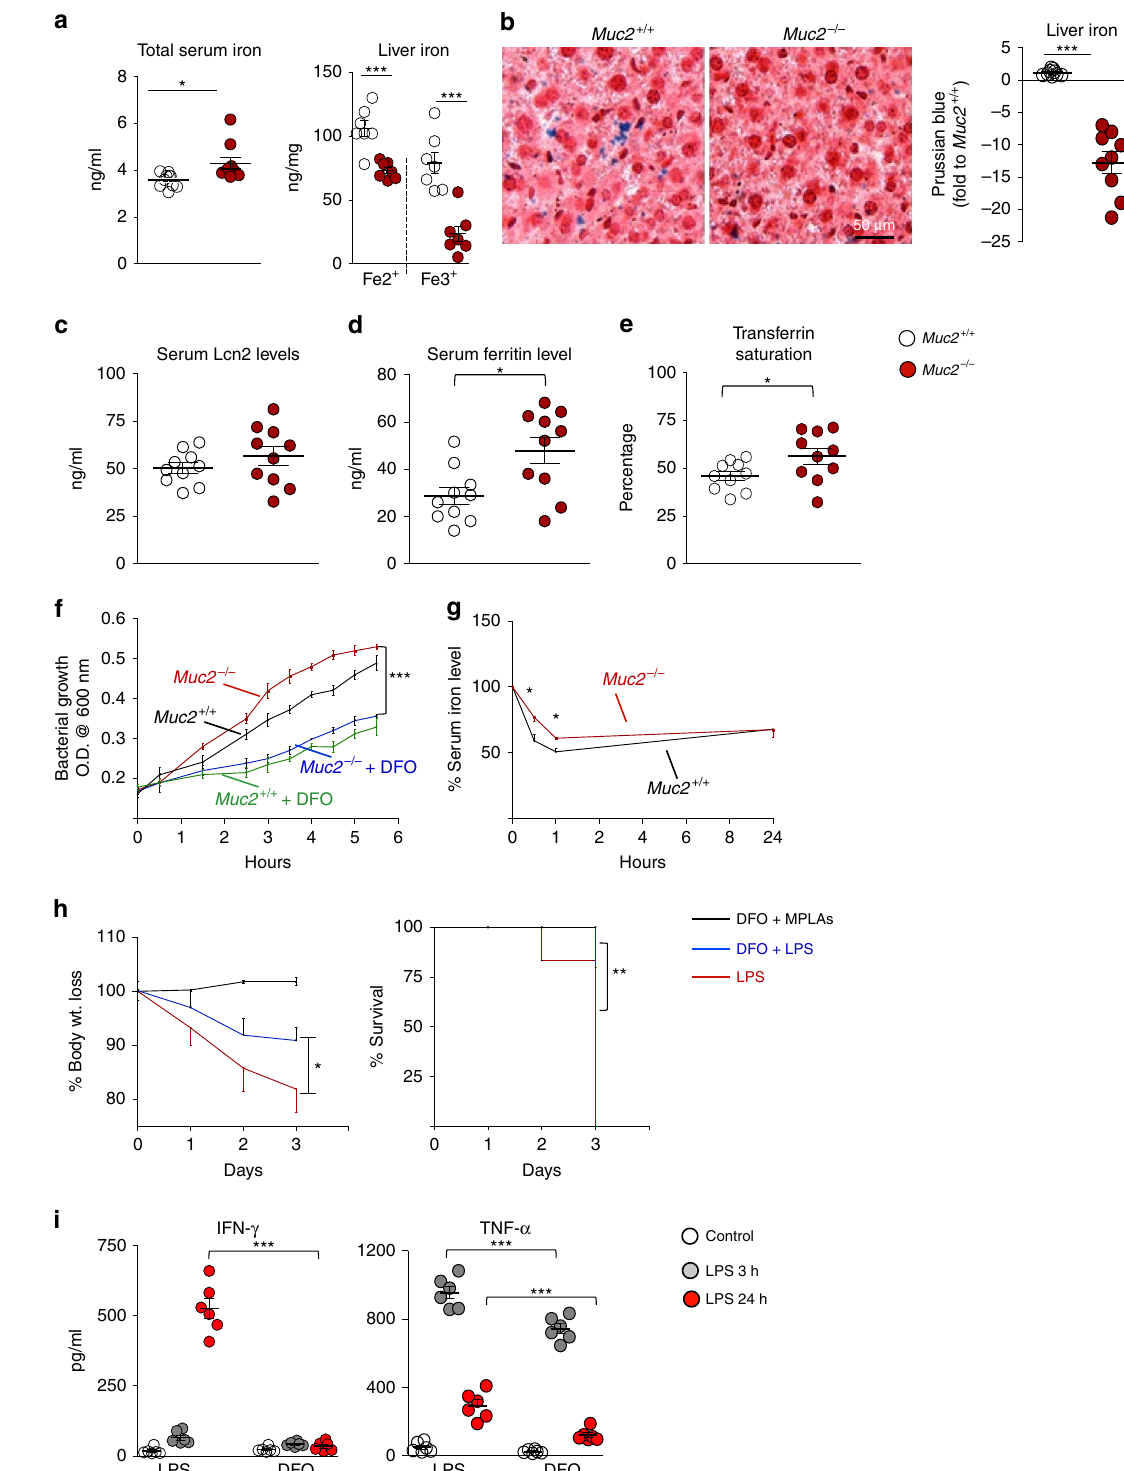
transferrin saturation levels and found higher serum ferritin and transferrin saturation levels in Muc2 − / − but not in Muc2 + / + littermates (Fig. 4d, e). Ferritin is regarded as an acute phase protein that is released in the circulation from damaged hepa- tocytes, thus high serum ferritin levels could suggest abnormal liver function in Muc2 − / − animals 33 . As expected, excess iron in the serum of Muc2 − / − promoted bacterial growth that